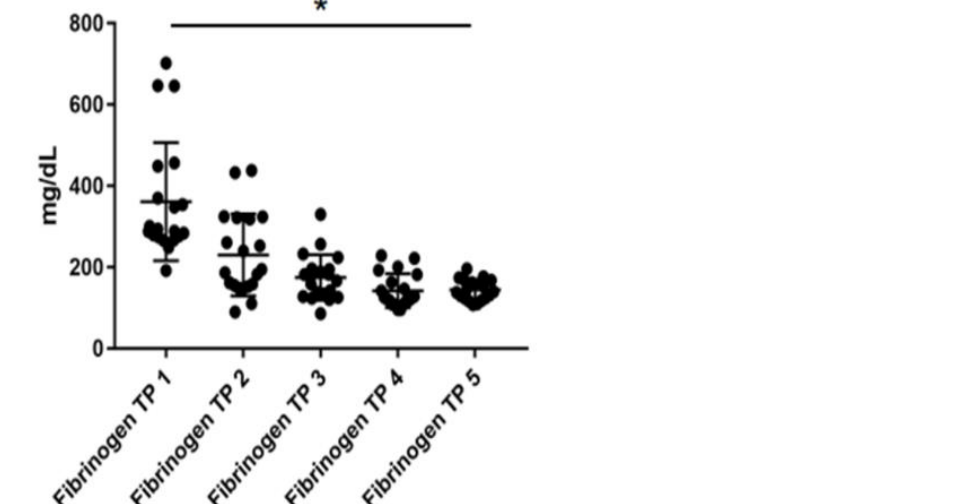
Figure 2. Levels of fibrinogen at five different timepoints (TP) during total plasma exchange proce- dure. * = p < 0.05. Significant difference between TP 1 and every following TP.